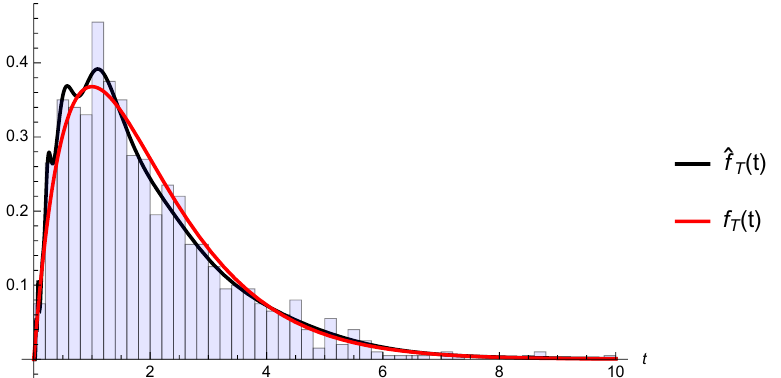
Figure 4. Comparison of the jump time density and its estimated analogue together with the used data depicted in a histogram.